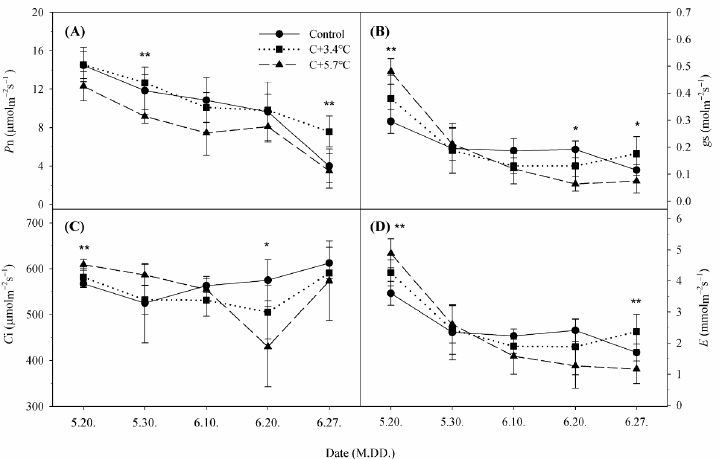
Figure 2. Changes in net photosynthetic rate ( A ), stomatal conductance ( B ), intercellular CO 2 concentration ( C ), transpiration rate ( D ) at 1200 μ mol·m − 2 ·s − 1 under different temperatures and a carbon dioxide concentration of 700 μ mol·mol − 1 during the 2019 growing season. The solid circle, square and triangle represent control, C+3.4 °C and C+5.7 °C respectively. Vertical bars represent the standard error of means from five replications. The asterisks * and ** indicate significant difference at p ≤ 0.05 and p ≤ 0.01, respectively. The light-curve was plotted using the photosynthetic rate measured on 20 May (10 DAF) and 27 June (48 DAF), and photosynthetic characteristics were calculated using the light-curve (Figure 3, Table 1). The maximum photosynthetic rate of all treatments de- creased after harvest (48 DAF), particularly that of the C+5.7 °C treatment, which de- creased by 74% and was the lowest at 3.25 μ mol·m − 2 ·s − 1 . The dark respiration rate showed no significant difference, but it tended to increase as temperature increased. The apparent quantum yield of all treatments decreased after harvest (48 DAF), whereas the light com- pensation points of all treatments increased after harvest (48 DAF). The light saturation points of all treatments were similar at 980–1100 μ mol·m − 2 ·s − 1 on 20 May (10 DAF); how- ever, on 27 June (48 DAF), those of the control and C+3.4 °C treatment increased, whereas that of the C+5.7 °C treatment decreased by 29% to 700 μ mol·m − 2 ·s − 1 (Table 1).